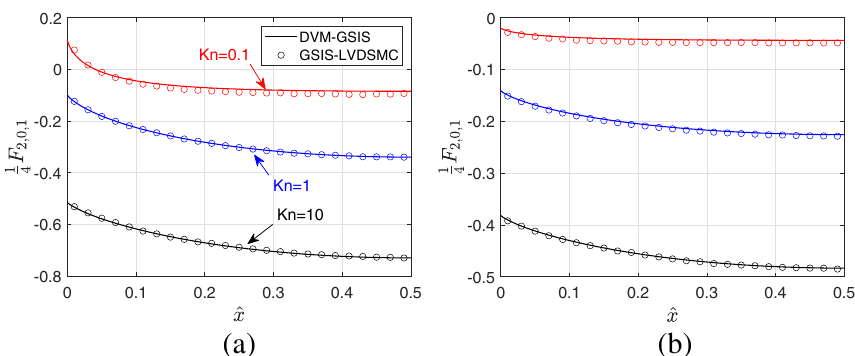
Fig. 3 High-order term 1 4 F 2,0,1 obtained from GSIS-LVDSMC and GSIS-DVM [22] at different Knudsen numbers. a Poiseuille flow. b Thermal transpiration. Note that the solution from the GSIS-DVM is chosen as the reference